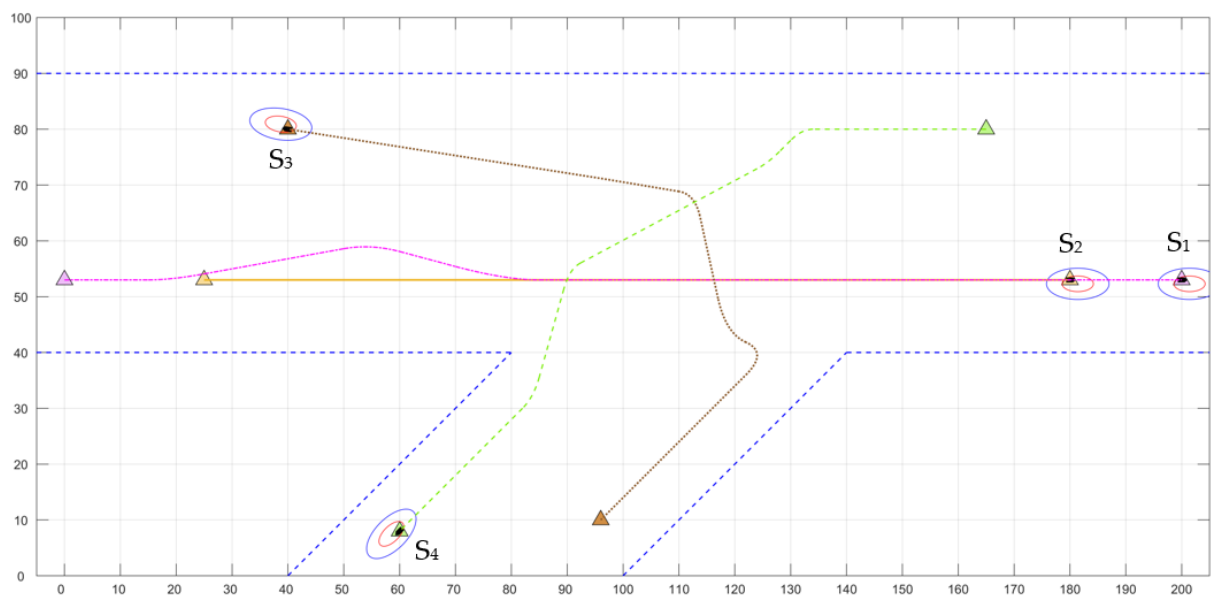
Figure 18. Scenario III of collision avoidance in a multi-ship situation.